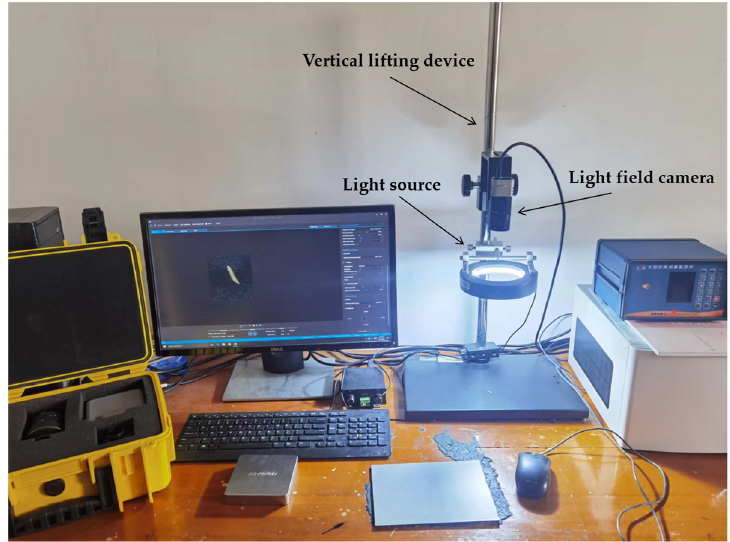
Figure 1. Point cloud collection hardware platform.